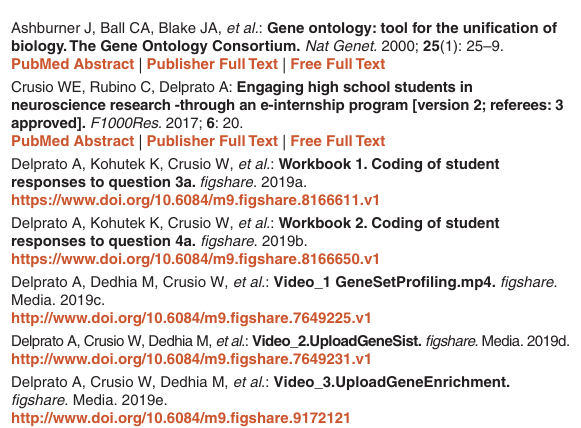
Figshare: Extended data 2. Video 2. UploadGeneSet Instruc- tional video for generating a random geneset and submitting this geneset to DAVID for Gene Ontology classification, https://doi. Figshare: Extended data 3. Video 3. GeneEnrichment Instruc- tional video for performing a gene enrichment exercise at the Gene Ontology site (http://geneontology.org/) https://doi. org/10.6084/m9.figshare.9172121 (Delprato et al .,